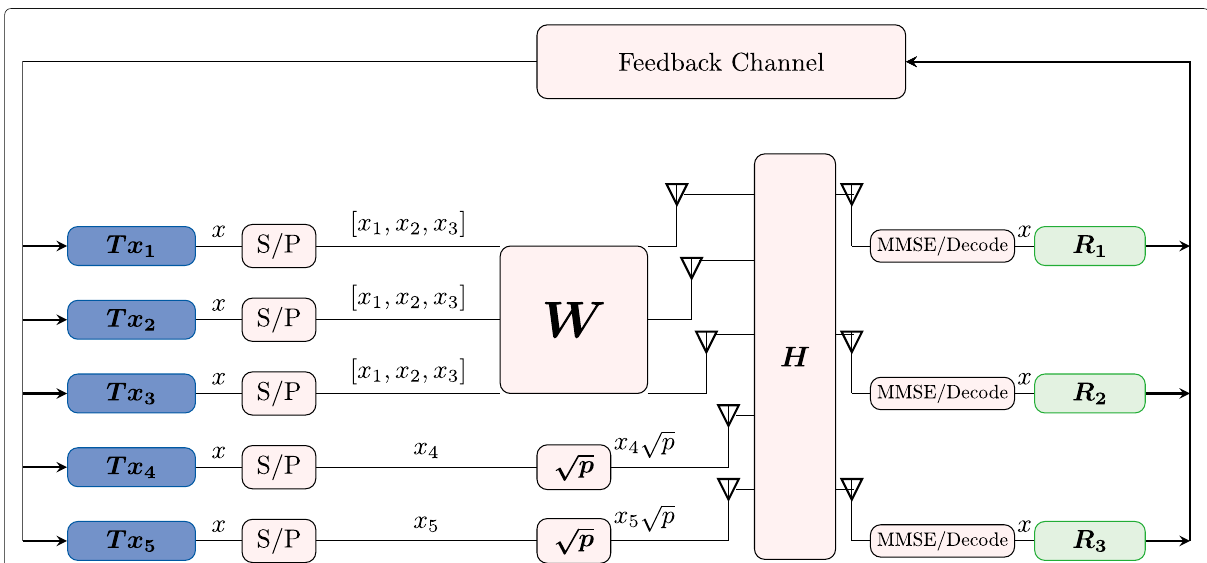
Fig. 2 System model. System model of the single-hop multicast beamforming consisting of K transmitting nodes and L receiving nodes. K 1 = 3 nodes are cooperating and K 2 = 2 nodes are operating individually, where K = K 1 + K 2 = 5. Feedback channels FB l are considered to be error